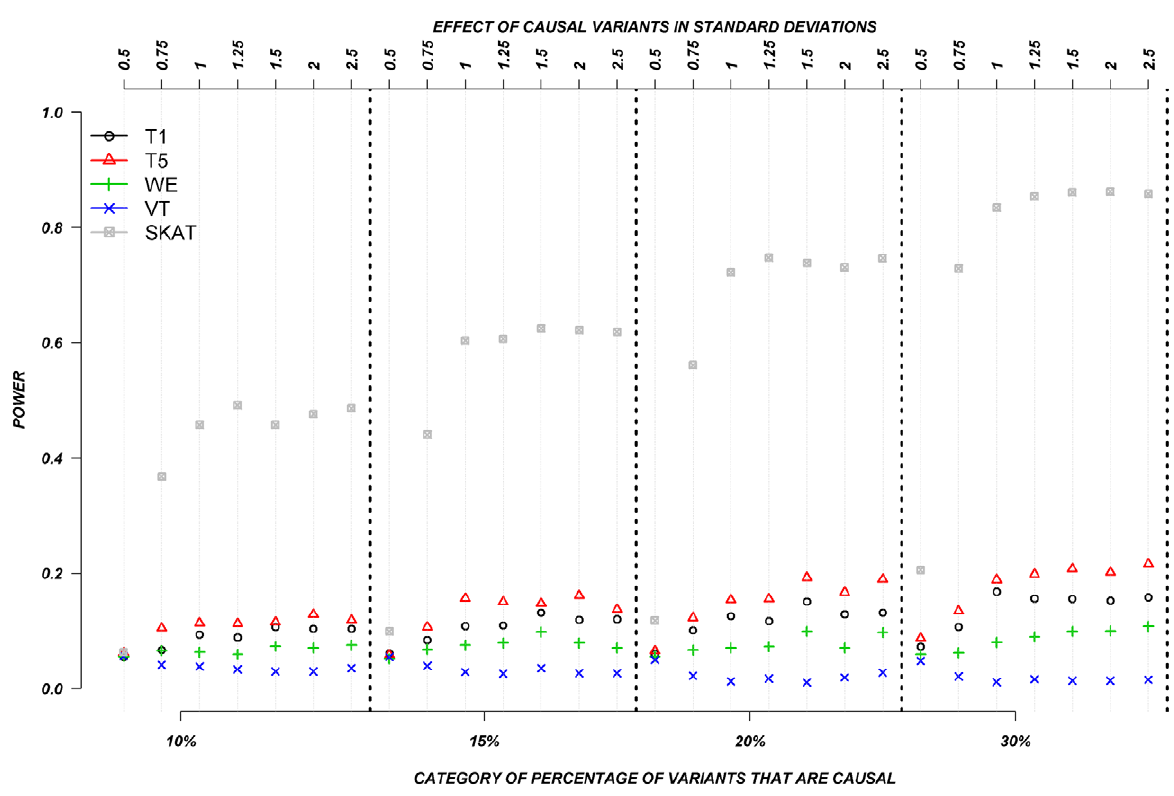
Figure 6. Dichotomous traits: Relationship between effect size, proportion of causal variants, and power, when causal variants are a mixture of protective and deleterious effects. Each box corresponds to a different proportion of causal variants involved in the relationship between rare variants and continuous traits (from left to right, 10, 15, 20 and 30%). On the x-axis, effect sizes are in standard deviations and correspond to the absolute value of the average size